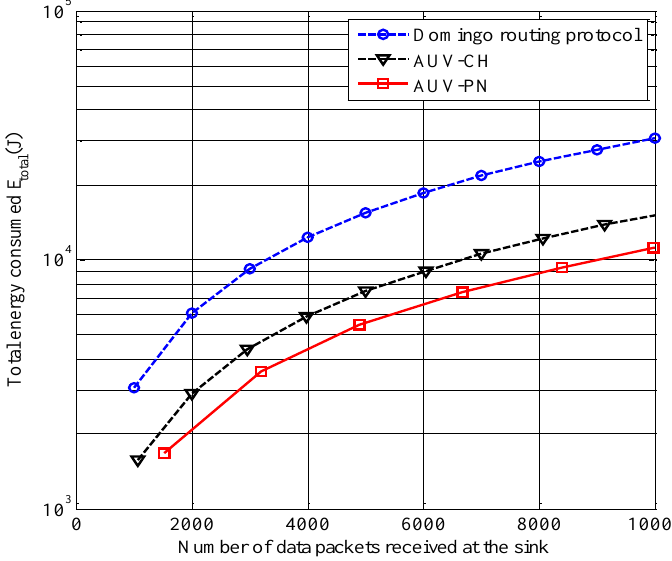
Figure 8. Total energy consumption versus the number of data packets gathered at the